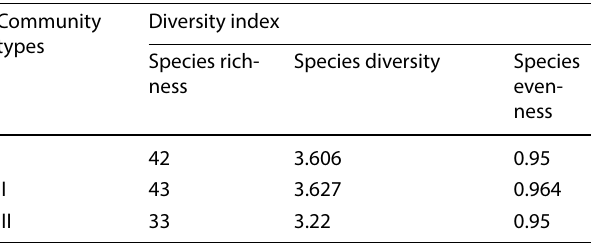
Table 2 Species richness, diversity and evenness of species between community types